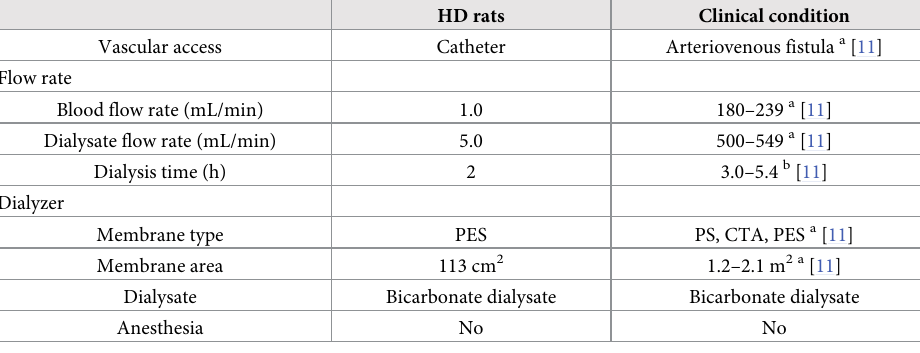
Table 1. Hemodialysis conditions of HD rats compared with clinical setting.